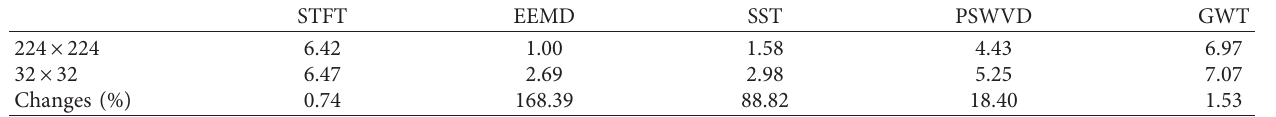
Table 2: Image entropies obtained from TFRs of different